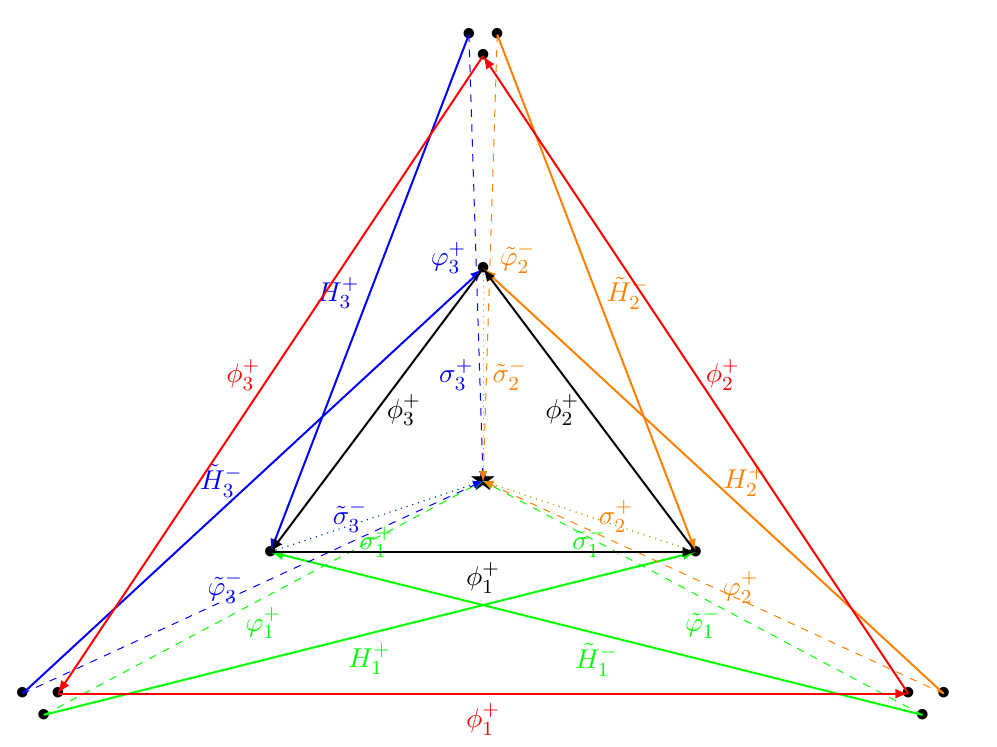
Figure 8. The various Higgs (cid:12)elds for the background of C [ (cid:22) L ] and C [ (cid:22) R ] brane together with a point brane D . Here, we picture C [ (cid:22) L ] as the outer most brane and place the point brane in the